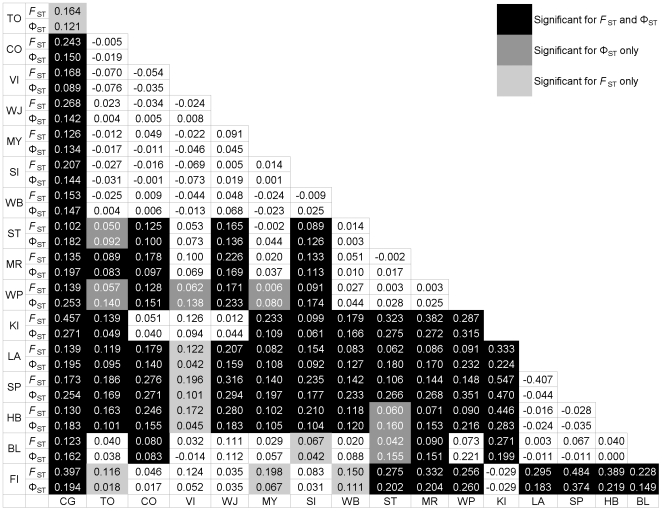
Pairwise F
ST and ΦST values between each pair of collection sites.Significant values are indicated by shading (P<0.05). Negative values are equivalent to zero, indicating no differentiation between samples.